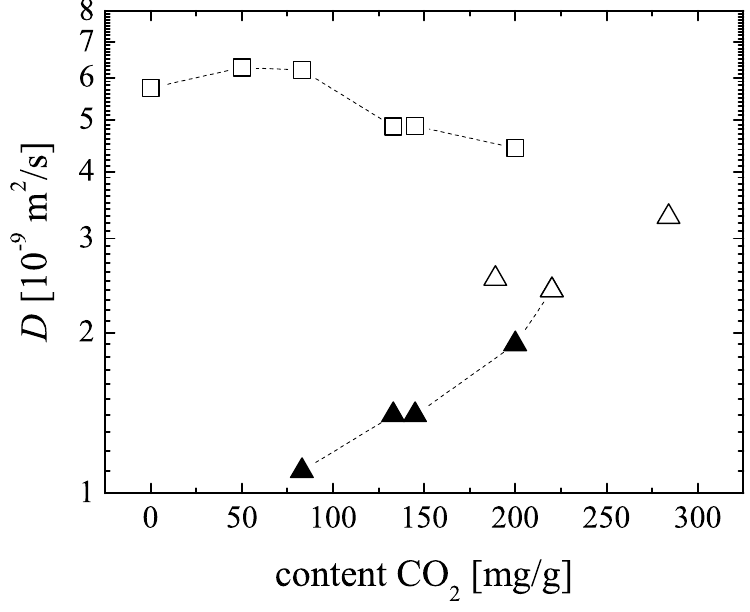
Figure 5. Self-diffusion coefficients D in MOF CuBTC in dependence on the adsorbed amount of CO : CO ( N ) and CH ( (cid:3) ) for the co-adsorption of both gases; CO 2 2 4 single component adsorption. The corresponding methane loadings and total loadings in molecules per u.c. are given in Table